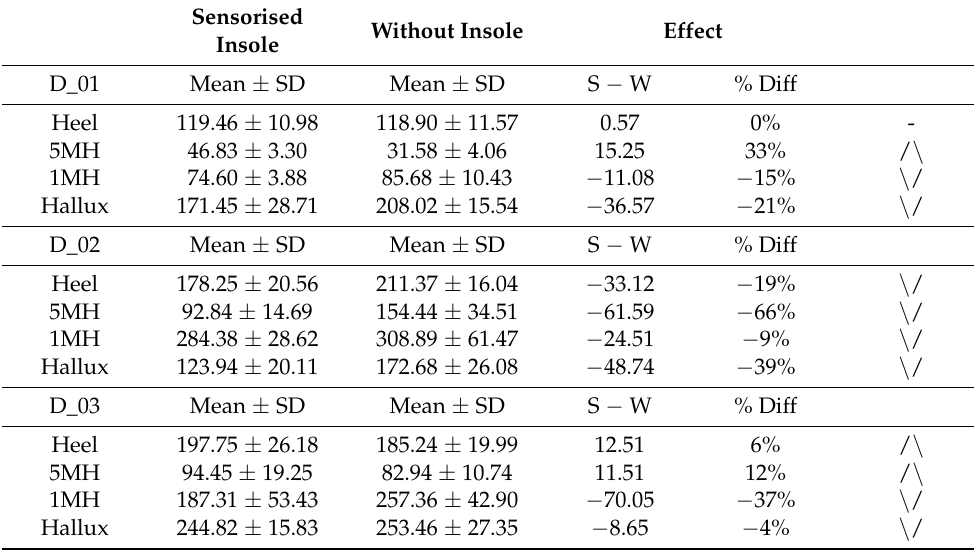
Figure 10. Mean peak plantar pressure distribution during walking obtained using the XSENSOR system with and without the sensorised insole. The four sensing locations are highlighted to allow regional peak pressure value comparison. The red dots represent the geometrical centre of each sensor. Table 1. Peak pressure safety evaluation for 5 participants with diabetes. MPP: Mean peak pressure values for each participant represent the average of 10 mid-gait steps. Effect calculated as absolute pressure with sensorised insole MPP minus without insole MPP (S −